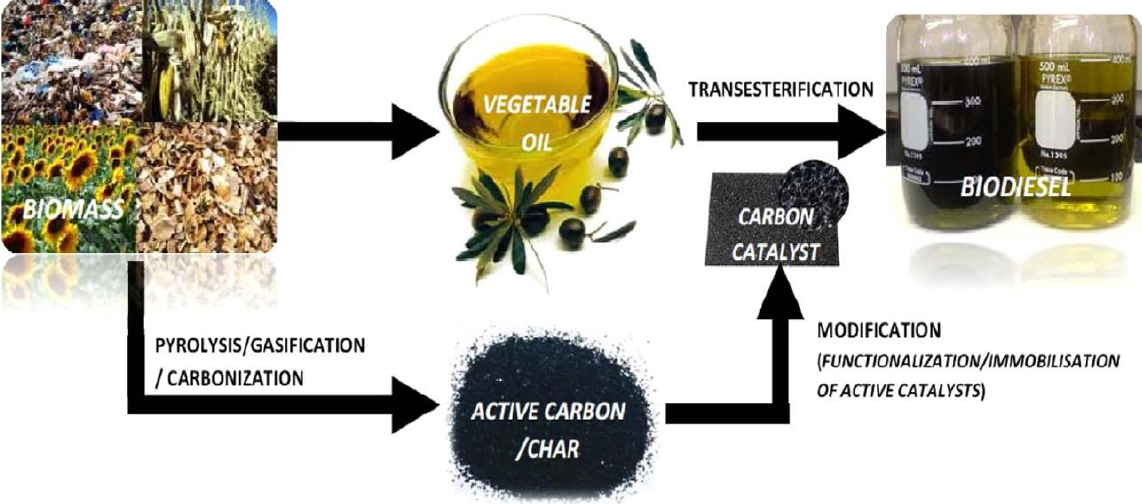
Figure 1. Schematic diagram for the synthesis of biodiesel by transesterification. Reprinted with permission from Ref. [12]. 2022, Elsevier.